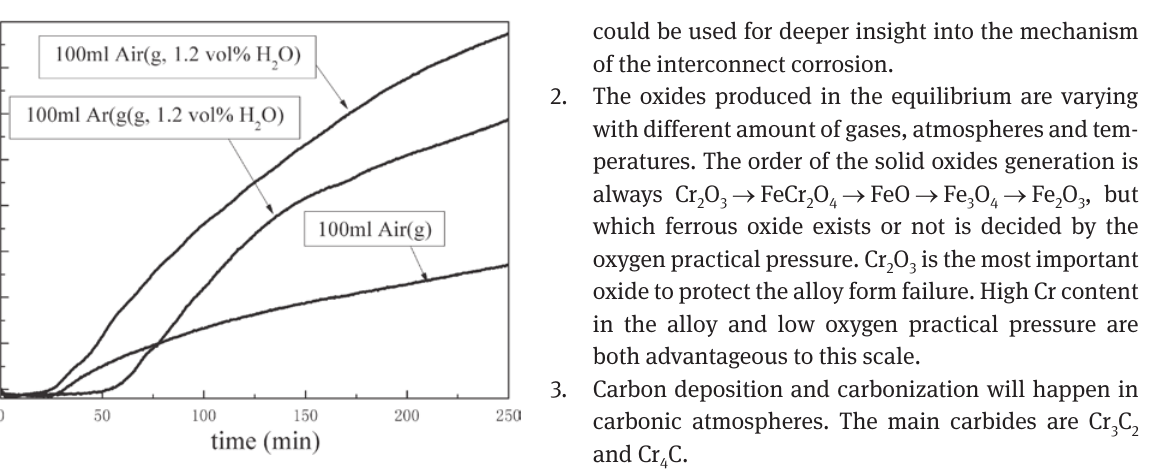
Fig. 10: The mass change curves of Fe-16Cr alloy at 1000 °C in different